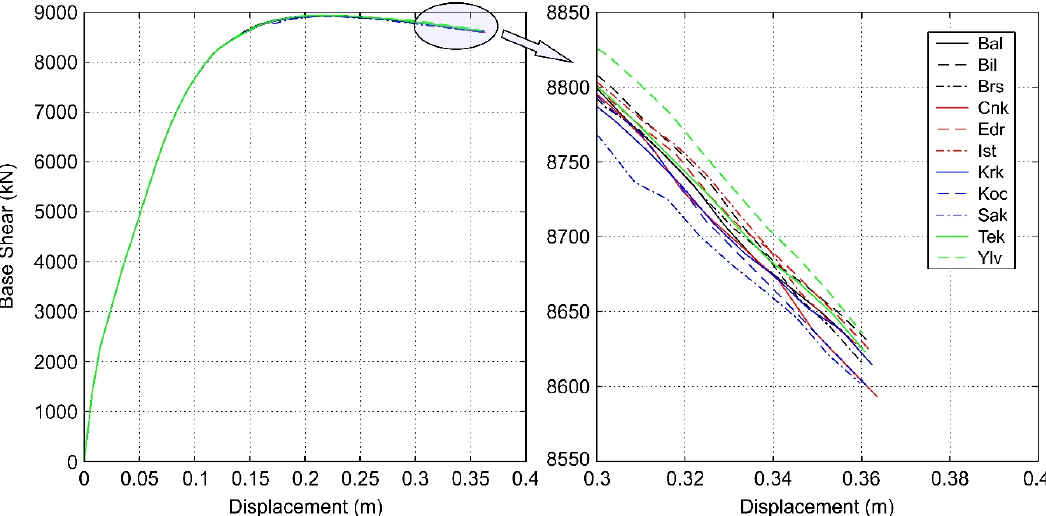
Figure 12. Comparison of pushover curves for 3-story.